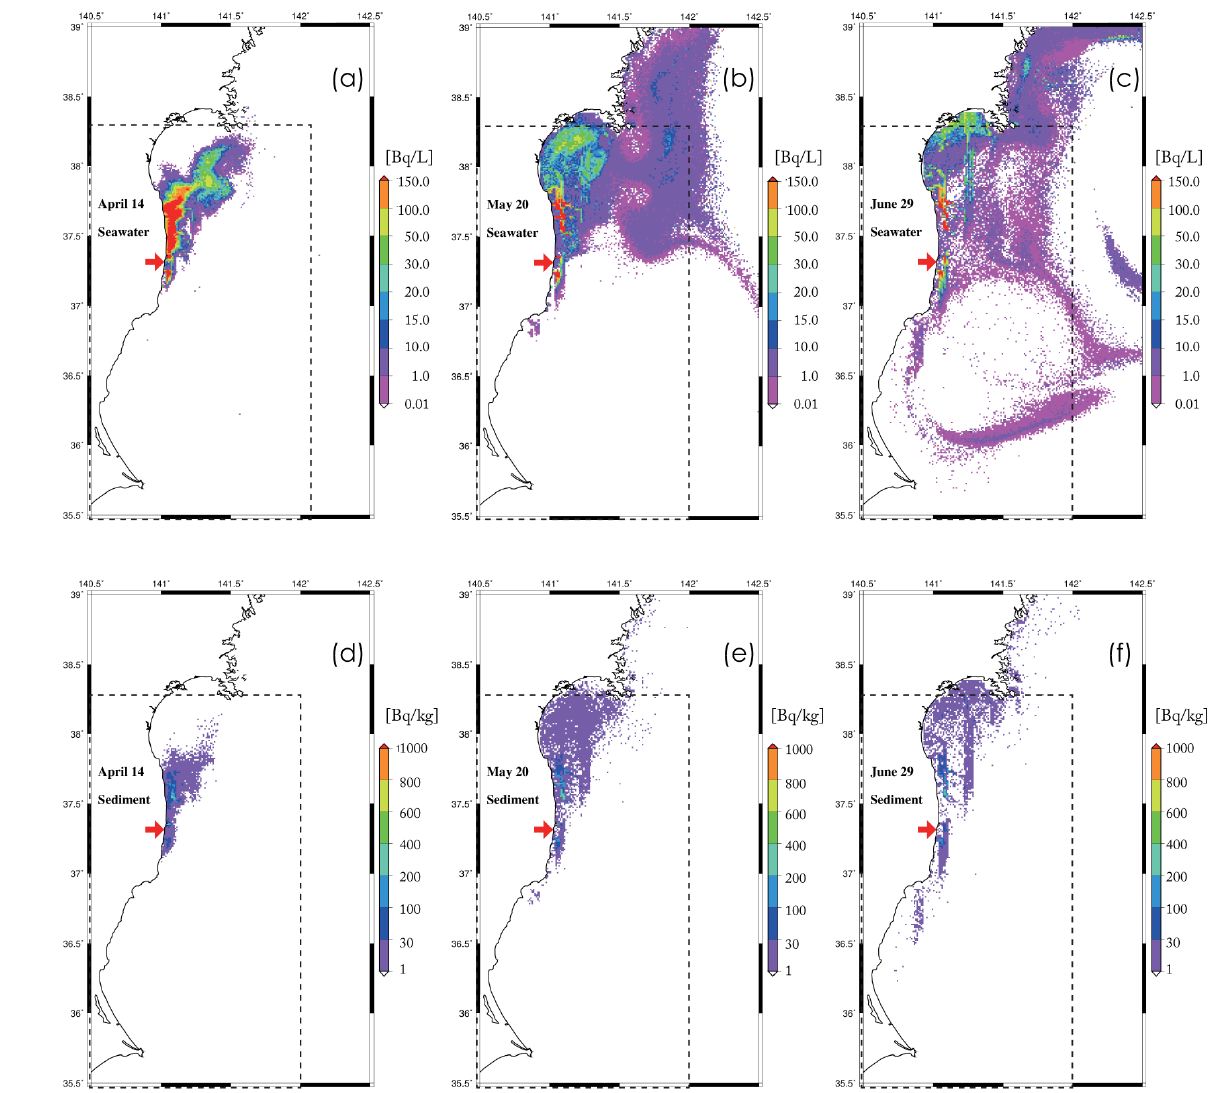
Fig. 9. Model results of SMIX. Depth-averaged radionuclide concentration in seawater phase (dissolved and LPM phases): (a) 14 April, (b) 20 May, (c) 29 June 2011. (d–f) Radionuclide concentration in bottom sediment phase: (d) 14 April, (e) 20 May, (f) 29 June